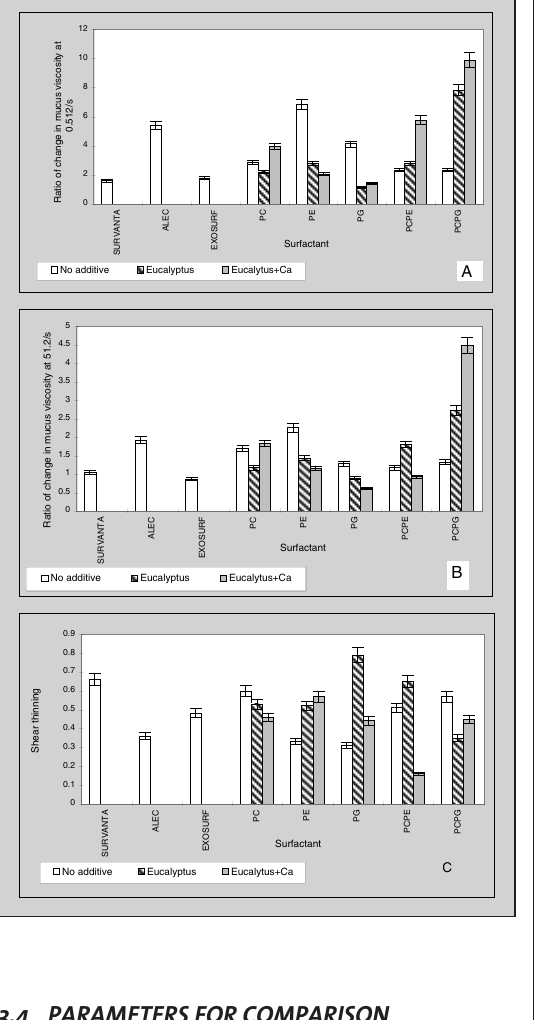
Figure 1 A-E (left): Power law fitted curves of phospholipid-eucalyptus added mucus gel simulant viscosity. Figure 2 A-C (right): Effect of phospholipid-euca- lyptus oil mixtures on rheology of mucus gel simulant (A lower value of each of the three para- meters is physiologically beneficial. All readings are the average of five experi- ments with a standard deviation <